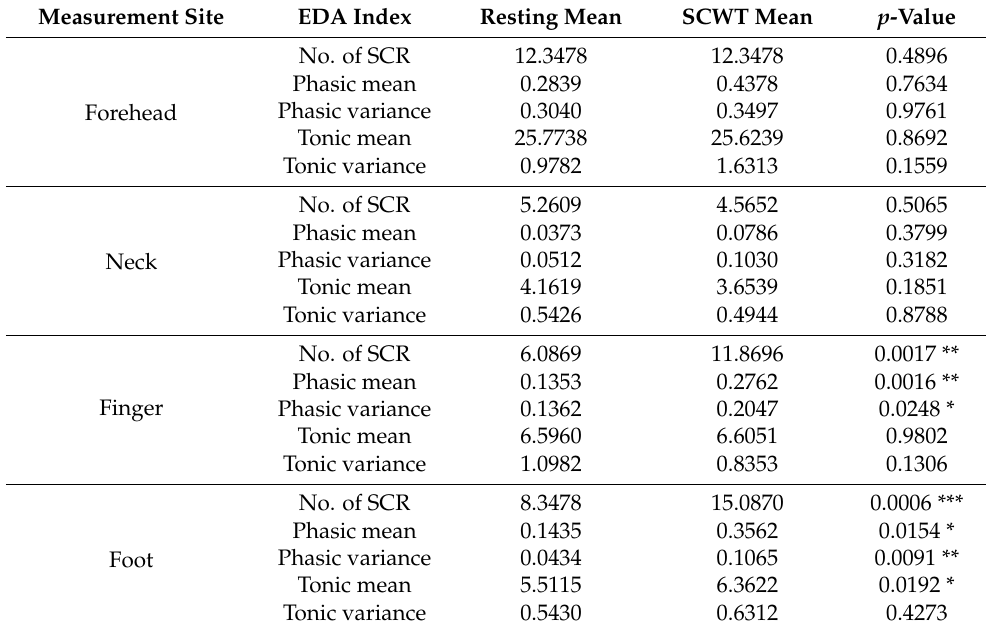
Table 3. Statistical t-test between the resting and SCWT stages.